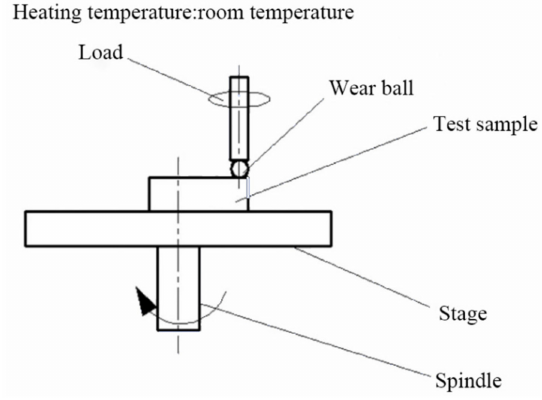
Figure 7. Schematic diagram of the friction and wear test. Table 4. Performance parameters of the friction and wear tester.